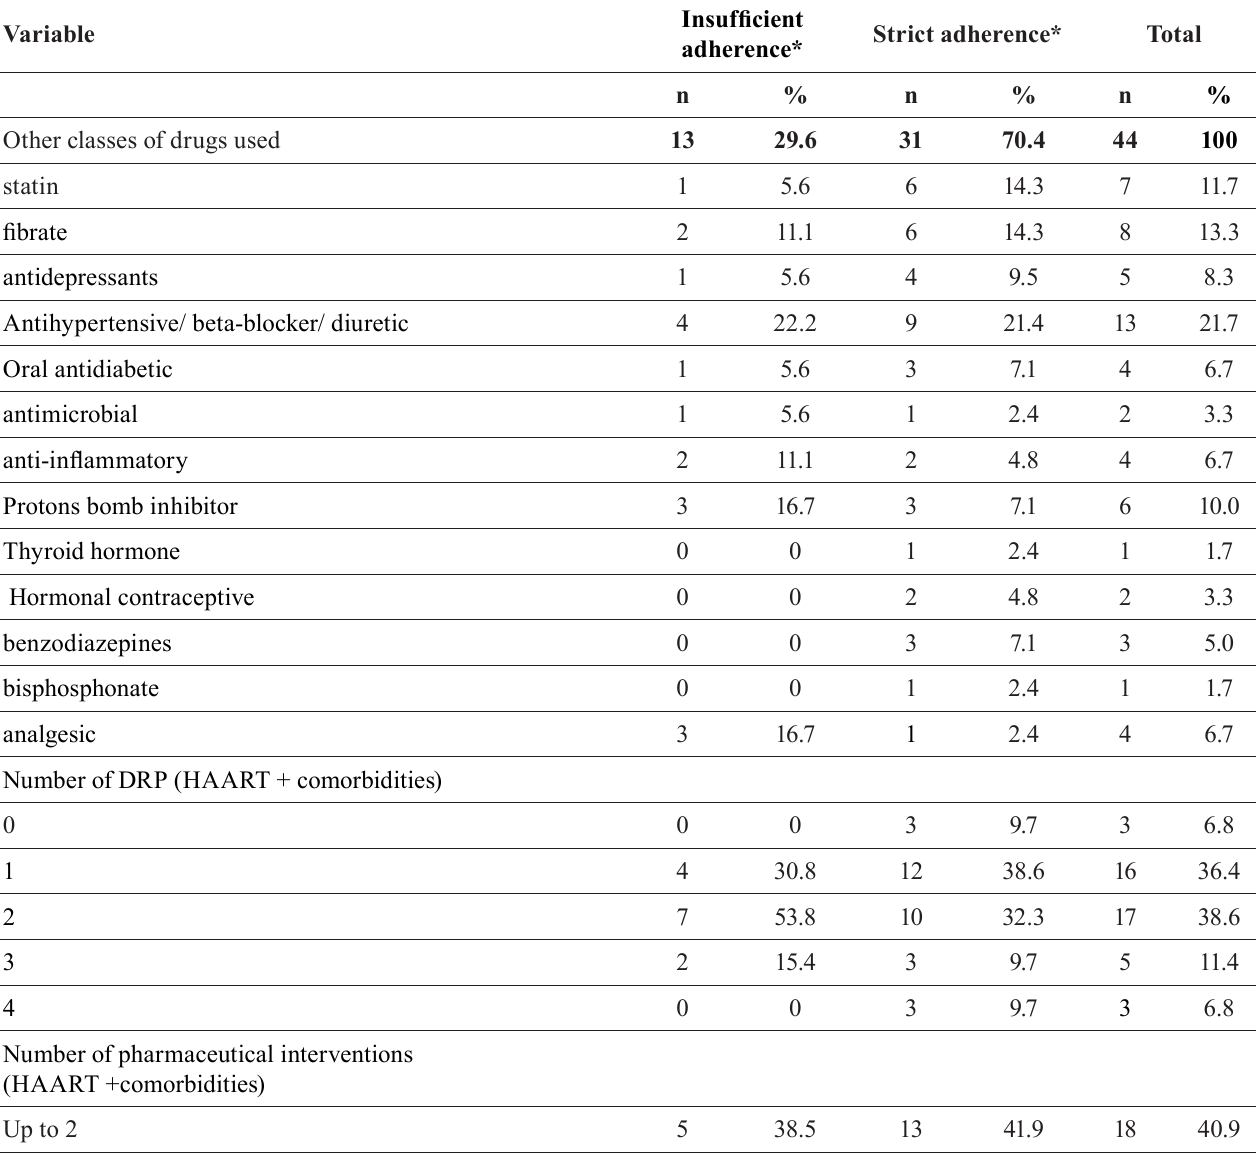
TABLE VI - Patient-related characteristics, according to CEAT-HIV adherence